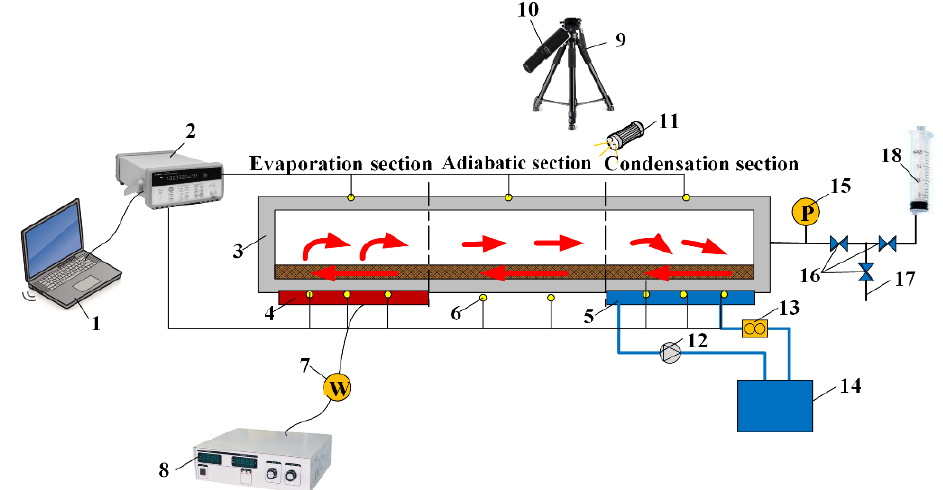
Figure 2. System diagram of visual and heat transfer experiments: 1-computer, 2-data collection, 3-MGFHP, 4-heat chip, 5-water jacket, 6-thermocouple, 7-watt meter, 8-power supply, 9-CCD camera, 10-microscope, 11-light source, 12-water pump, 13-flowmeter, 14-cold water storage, 15-pressure meter, 16-vacuum valve, 17-vent, and 18-injector.